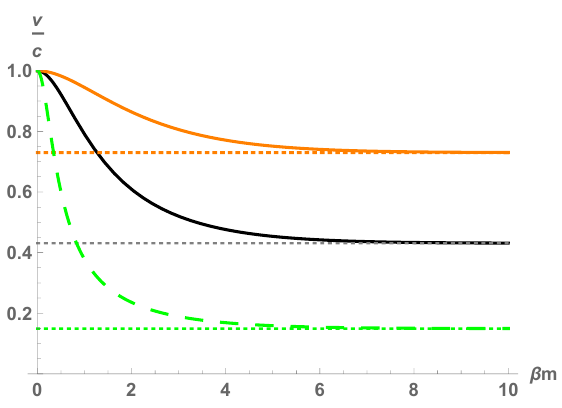
Figure 5 . The bubble speed v/c as a function of the scalar mass m/T for the same choice of the parameters as in figure 4: ∆ P = − 0 . 01 /β 4 (green dashed), ∆ P = − 0 . 1 /β 4 (solid black) and ∆ P = − 0 . 5 /β 4 (solid